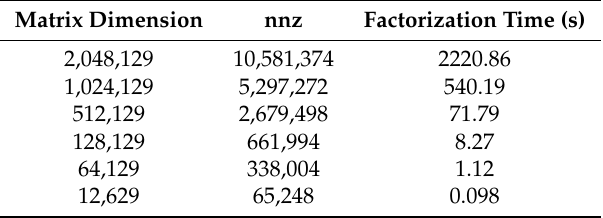
Table 1. Time required for pivoting, reordering a factorization for different sizes of sparse matrix. Matrix Dimension